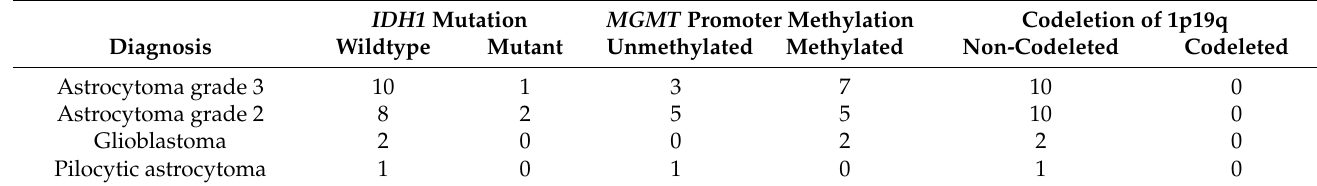
Table 3. Molecular diagnoses from infratentorial stereotactic